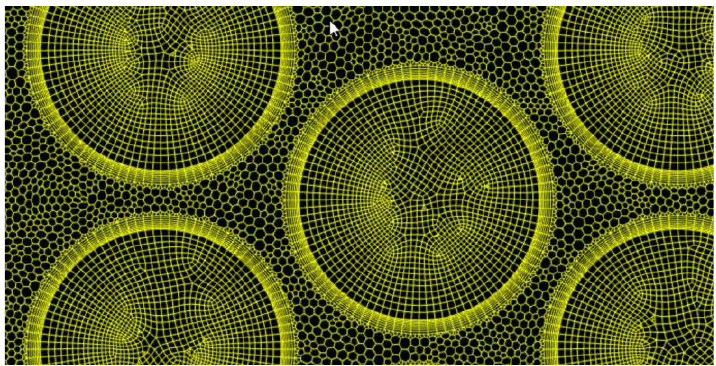
Figure 7. Detail of the used polyhedral numerical grid in a longitudinal section cross the computed domain.